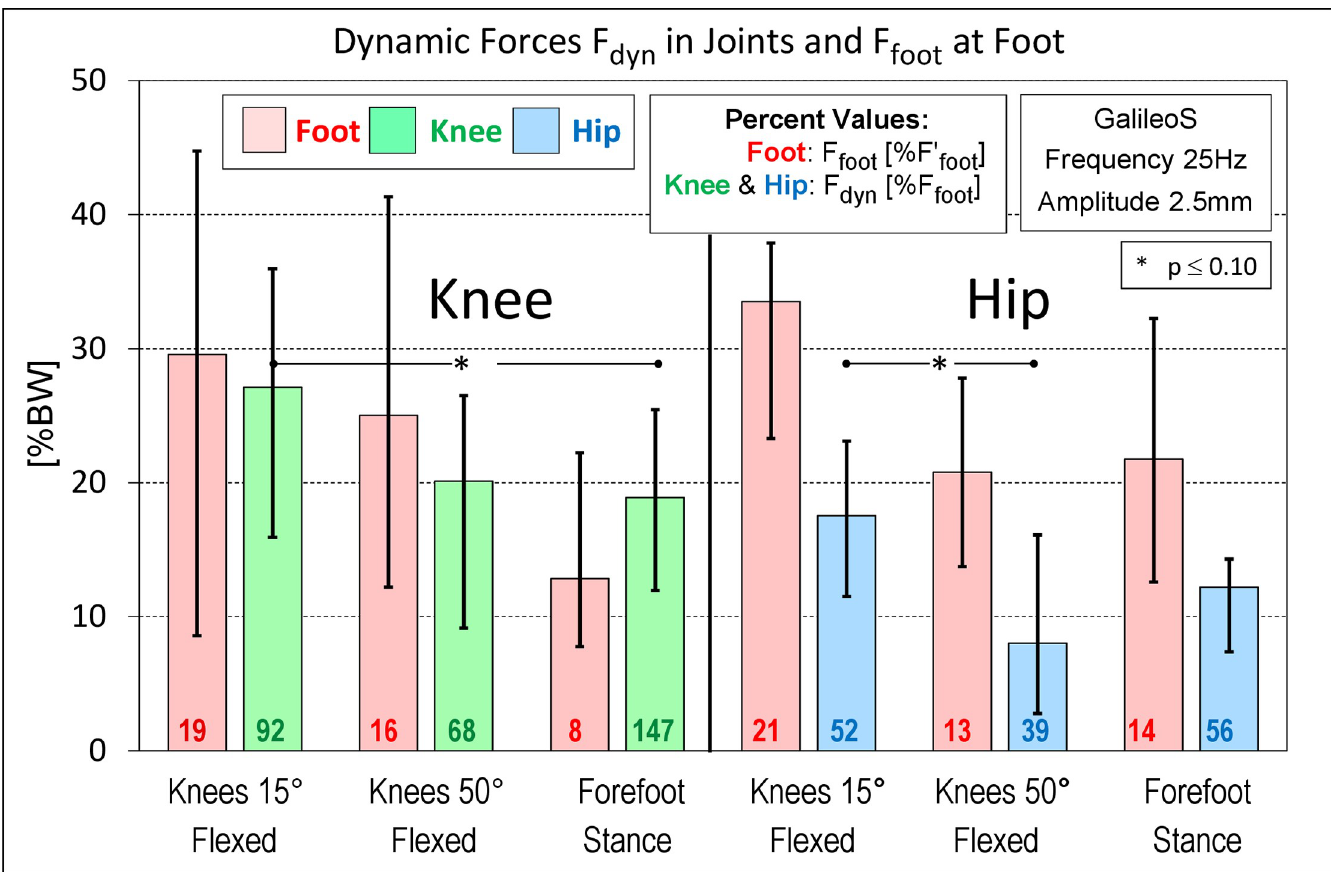
Fig 7. Dynamic force in the knee and hip joint in different body positions and comparisons to the dynamic force at the foot. Median values and ranges from the knee and hip joint for three different body positions. All data from GalileoS at 25 Hz, 2.5 mm. Red columns = measured force F foot at foot. Green/blue columns = dynamic force F dyn in the knee/hip joint. Percentage values at the bottom of columns: Red = measured force F foot as a percent of the hypothetical force F’ foot at the foot. Green/blue = F dyn as a percent of F foot . �� = significant change (p � 0.05), � = low significance (p �